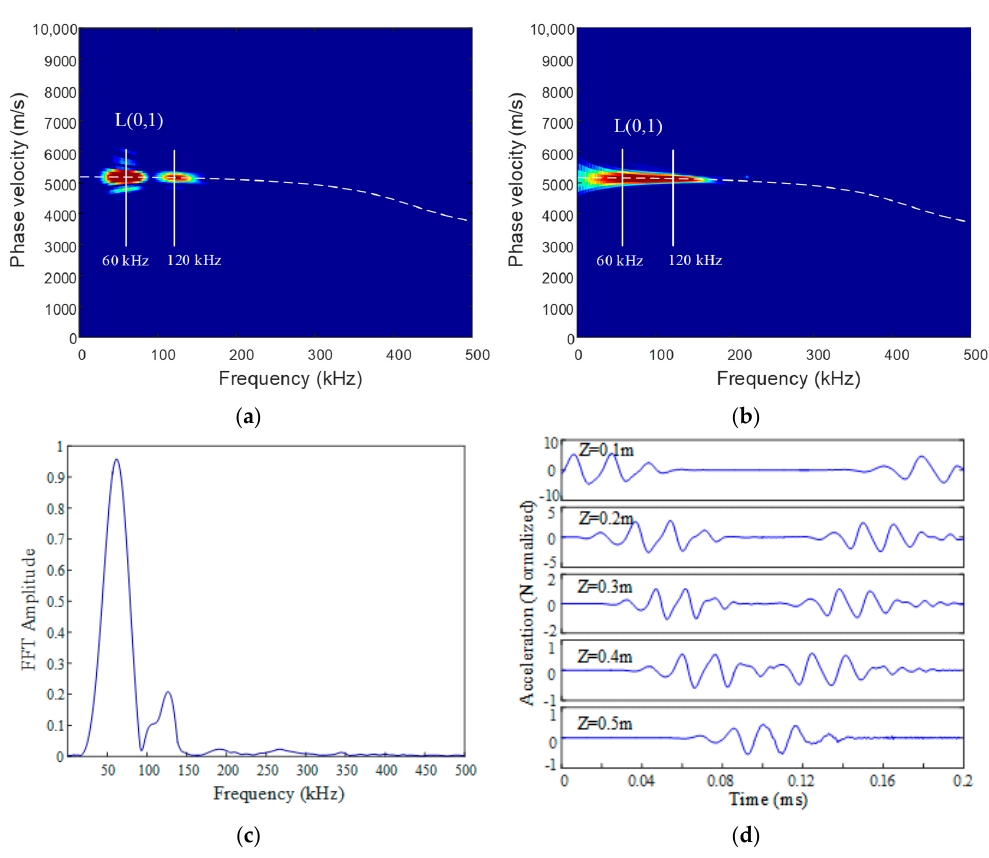
Figure 10. The phase velocity dispersion spectra of wires from nodal accelerations with a Hann-windowed, five-cycle, 60 kHz sinusoidal tone burst along the z -axial direction: ( a ) the active wire and ( b ) the passive wire. The theoretical dispersion curve of L(0,1) obtained in Figure 1a is represented by white dotted lines. ( c ) The FFT spectra of a representative received signal of the active wire and ( d ) part of the representative acceleration time-domain-received signals in the active wire. The CAN model described in Section 2.2. and the energy transfer model described in Section